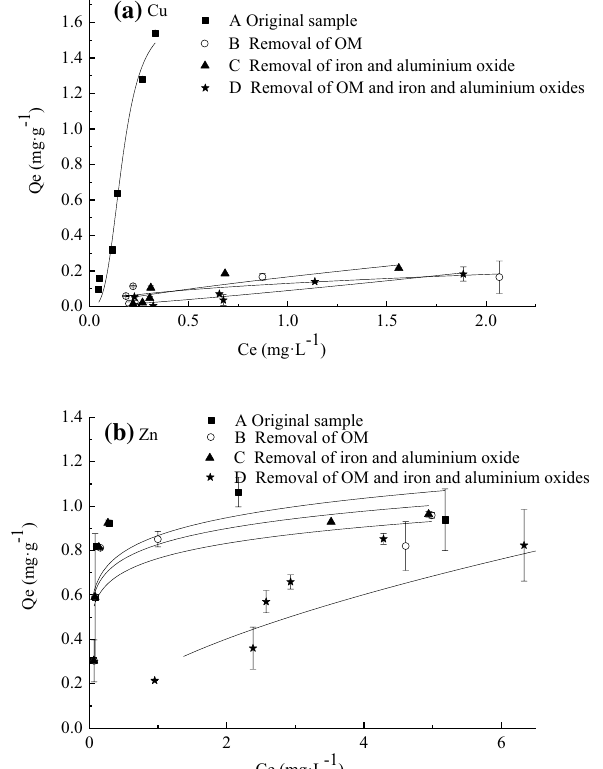
Figure 4. Isotherm adsorption curves. ( a ) Cu, ( b ) Zn.